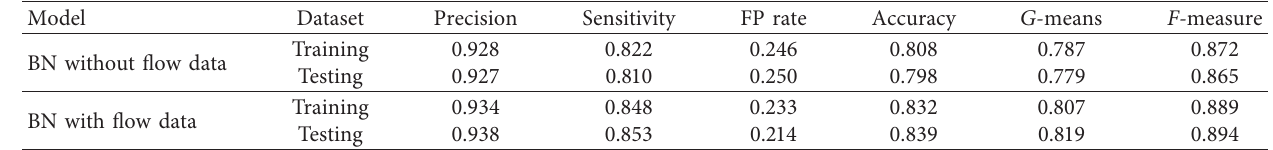
Table 5: Estimation performance of BN